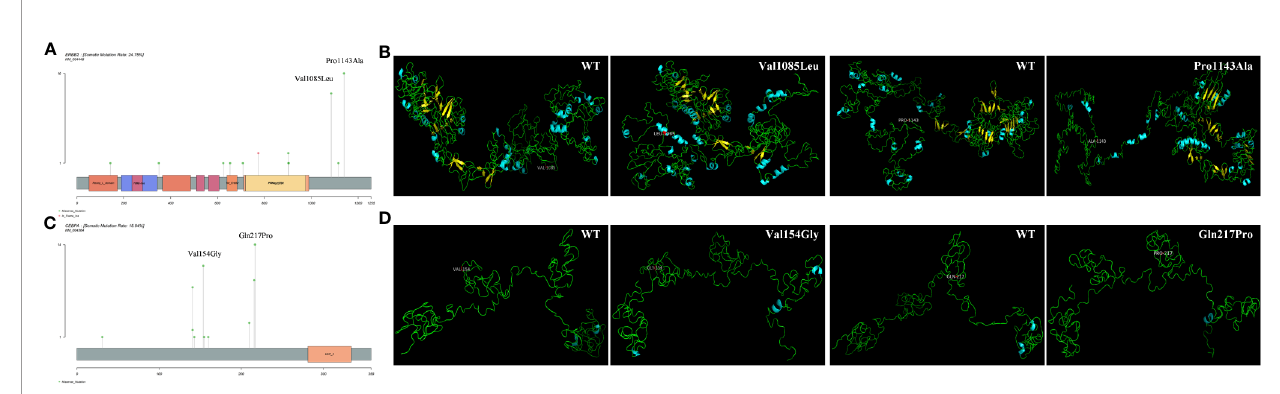
FIGURE 3 | Mutant points and 3-D protein structures of normal and mutant protein of ERBB2 (A, B) and CEBPA (C, D) . Blue means helix, green means sheet. The mutant points were shown in red in the structure diagram.